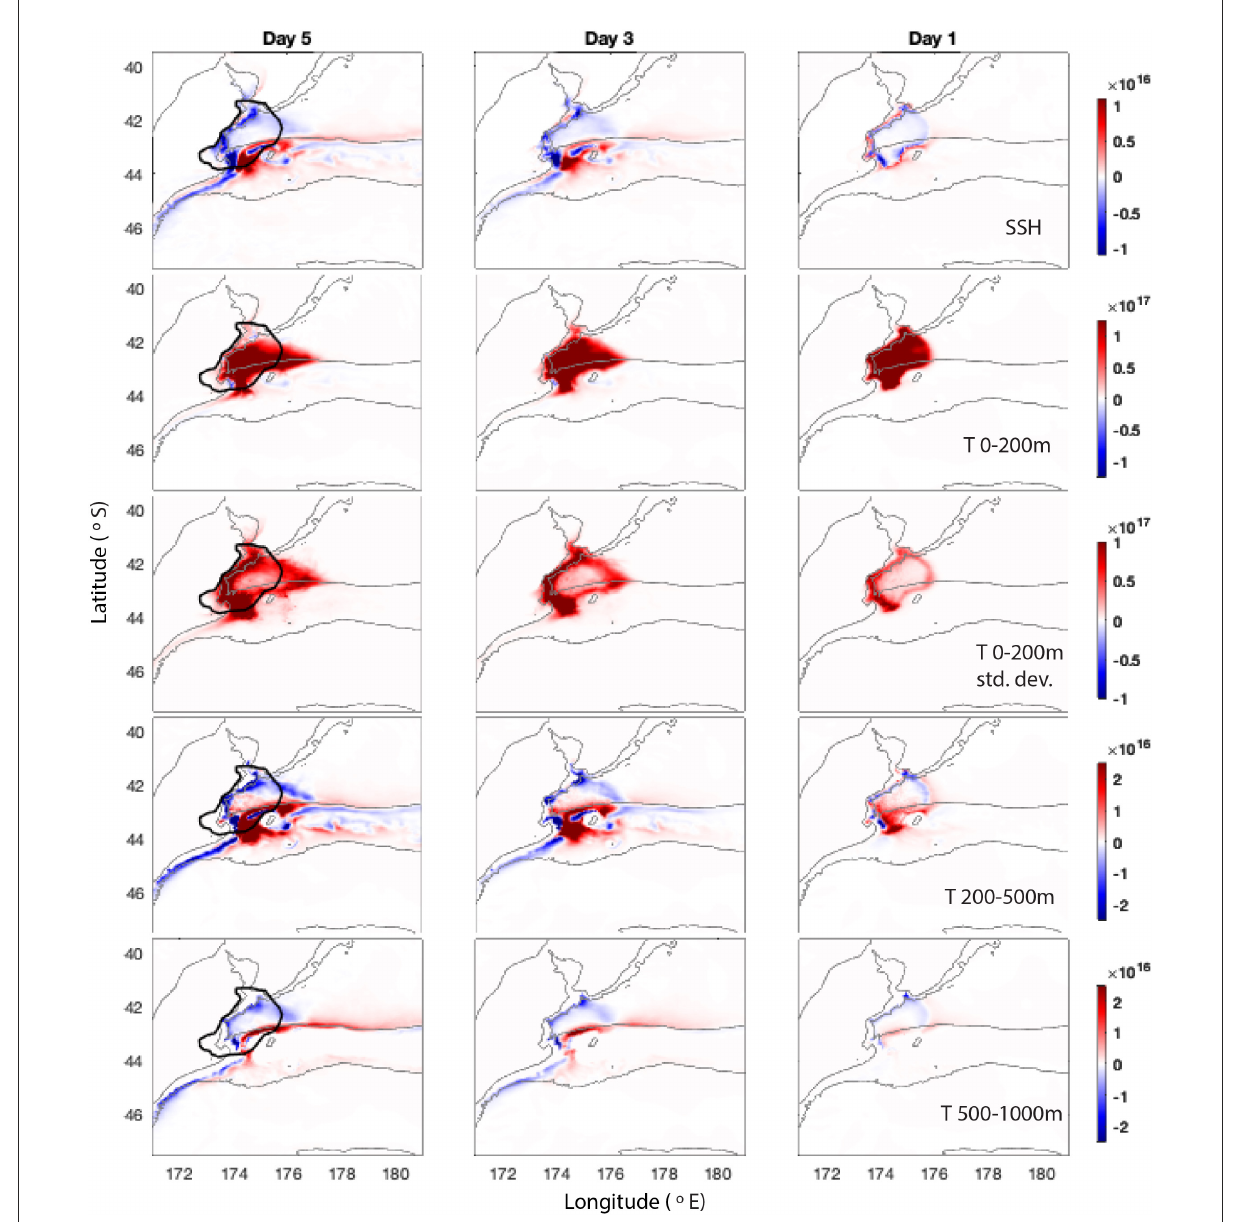
FIGURE10 Ensemble sensitivities for days 5, 3, and 1 leading up to all 64 MHW events in the Kaikoura region. (Top to bottom) : Mean scaled sensitivity to SSH, mean scaled sensitivity to temperature from 0 to 200 m, standard deviation of scaled sensitivity to temperature from 0 to 200 m, mean scaled sensitivity to temperature from 200 to 500 m and mean scaled sensitivity to temperature from 500 to 1,000 m. Sensitivities are scaled by the 5-day standard deviations for the days leading up to the MHWs, averaged in quadrature. Gray lines show the 100 and 1,000 m bathymetry